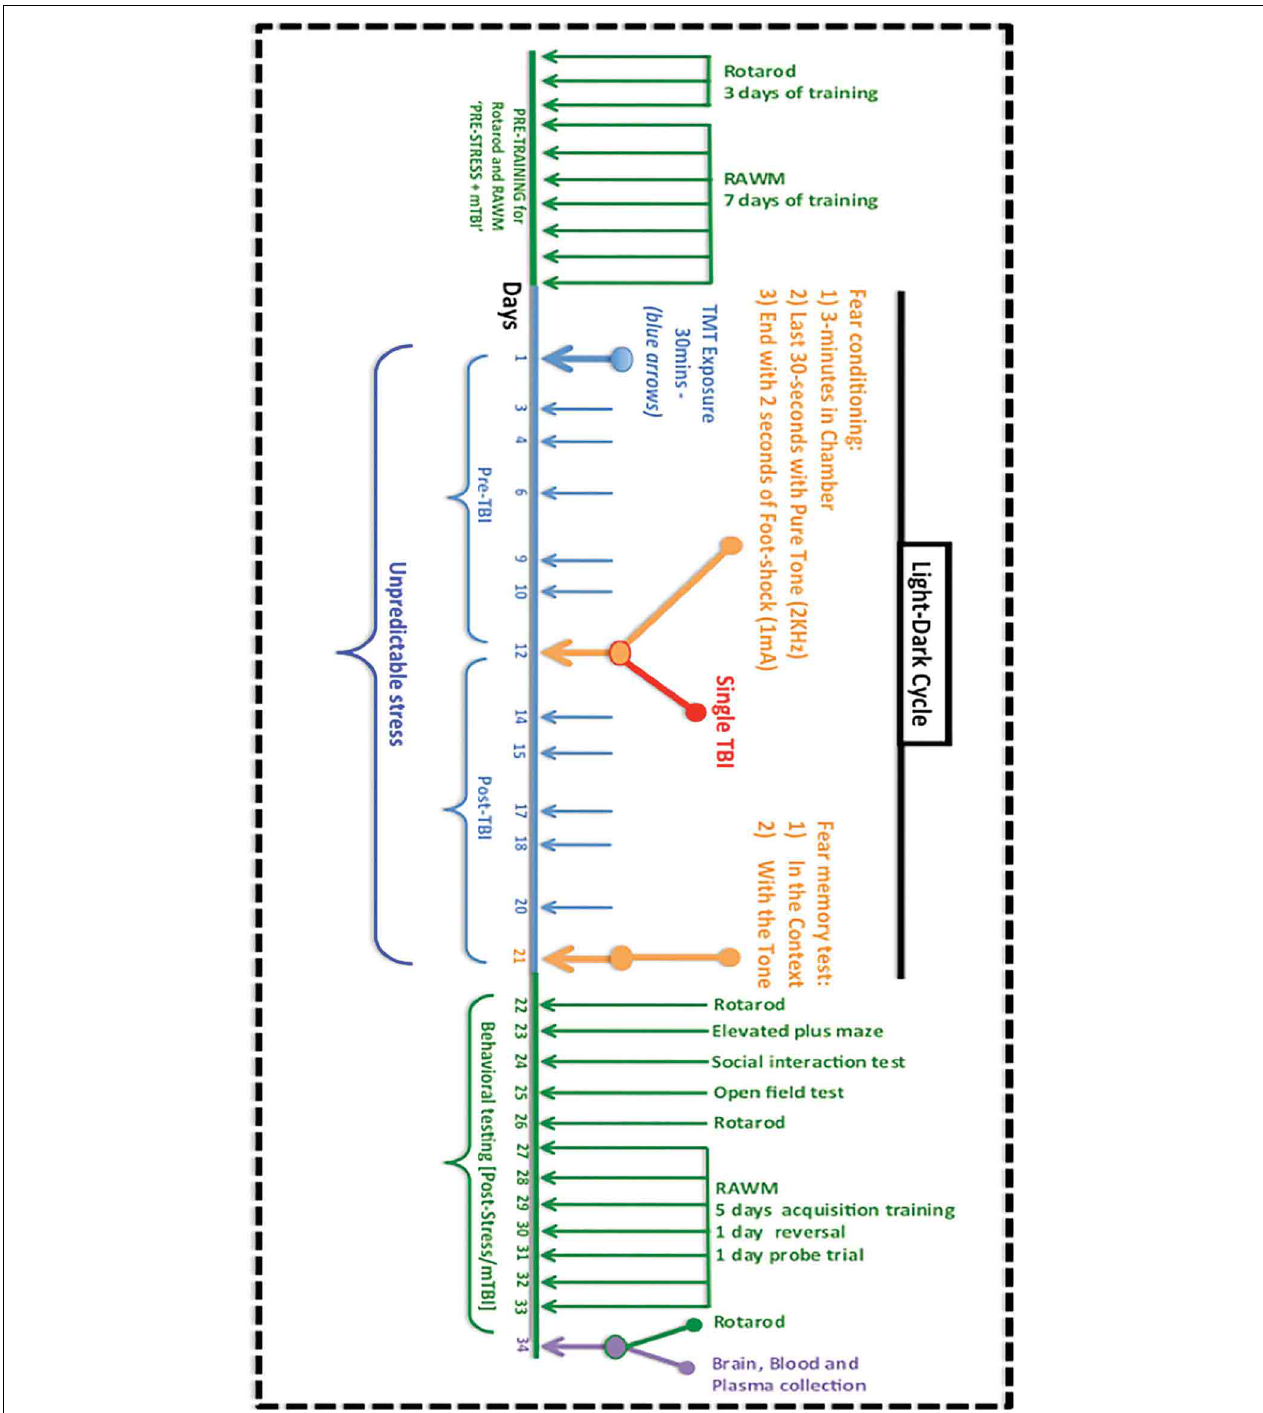
FIGURE 1 | Timeline and procedures for the experimental mTBI and PTSD paradigm. Mice were pre-trained to obtain their baseline fall latency values on the rotarod test for motor co-ordination for 3 consecutive days, and this was followed by a 7-day acquisition training in the radial arm water maze (RAWM) test for spatial learning and memory. The 21 day experimental paradigm involved an exposure to TMT and restraint on 11 randomly assigned days (blue) at different times of the light-dark cycle. Around the midpoint, on day 12, mice underwent fear conditioning, which involved being placed in a